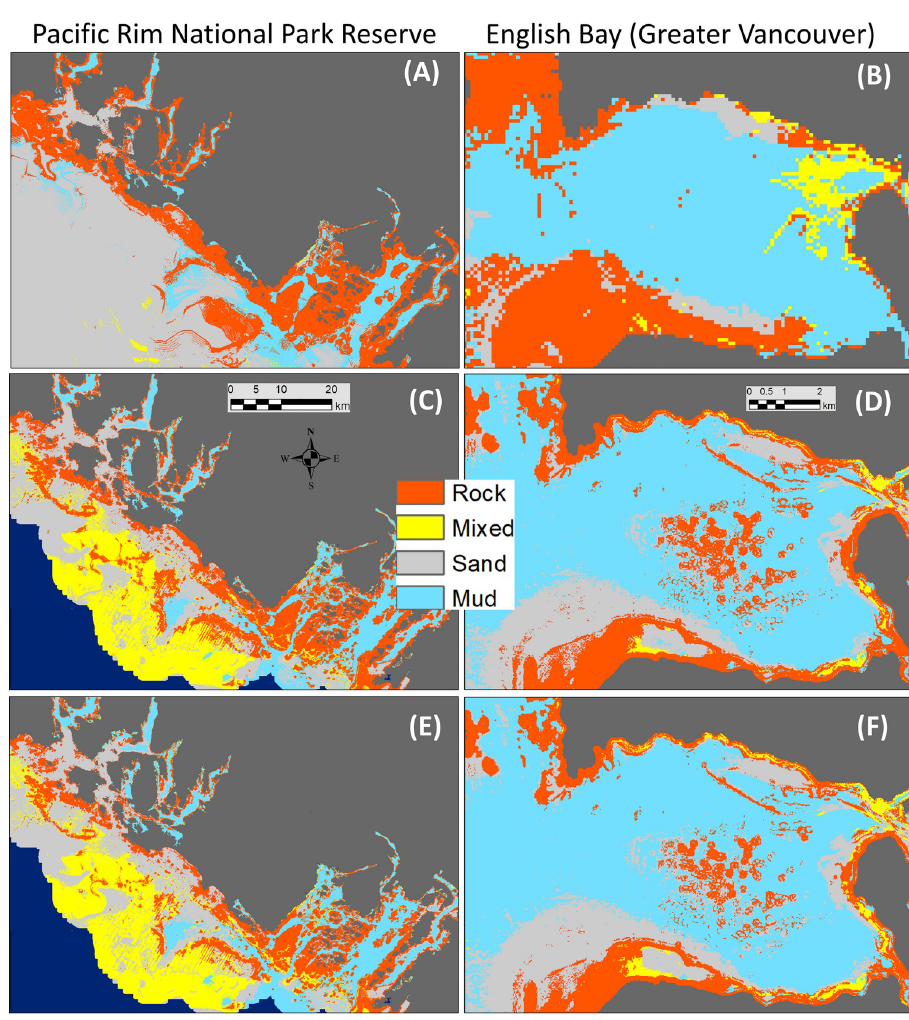
Fig 4. Predictions in regional assessment areas. Predictions from the 100 m coastwide (top row), 20 m, no-weight (middle row), and 20 m weighted (bottom row) models for the Pacific Rim National Park (left column) and Greater Vancouver (right column) assessment areas. The series of images (from top to bottom) shows how increased resolution and weighting for prevalence help mitigate the bias towards rocky